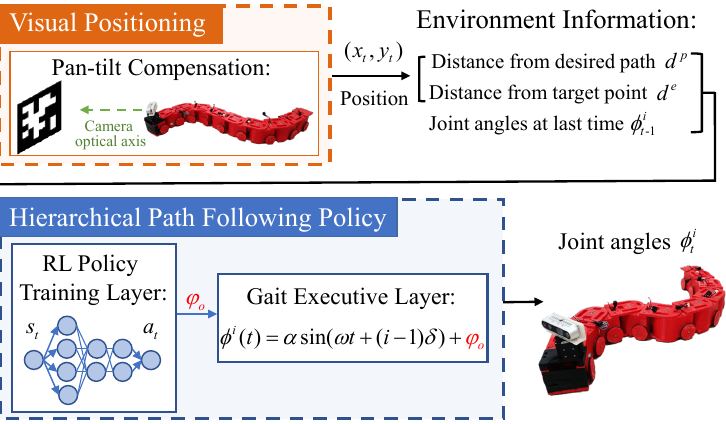
Figure 1. The overall control architecture of the proposed path following method, which consists of two stages: visual self-localization and hierarchical path following